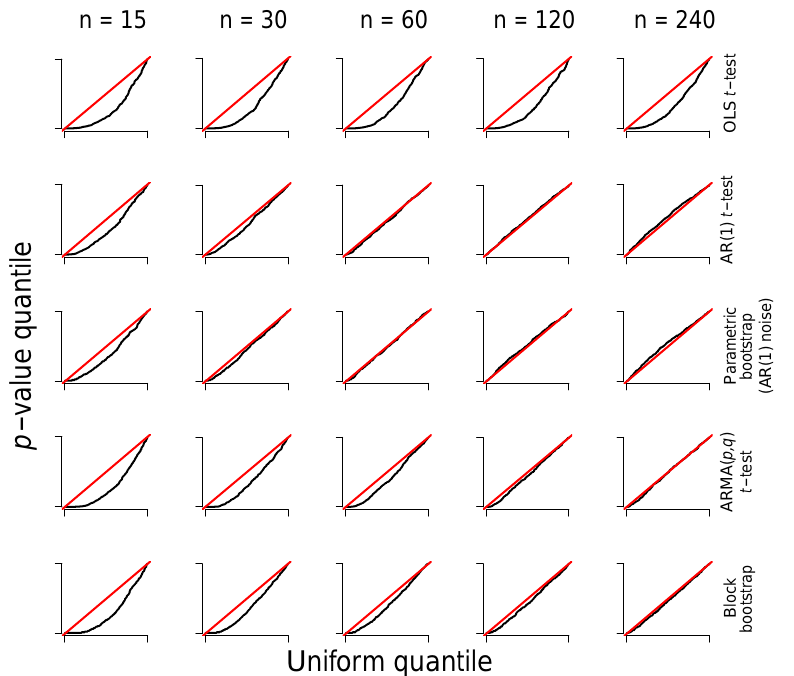
Figure 9. Same as Fig. 7 but with simulations from an ARMA(1,1) model. The p values calculated by incorrectly assuming an AR(1) model are increasingly conservative in larger sample sizes in this setting. Both blind selection via AICc and the block bootstrap are anti-conservative for small sample sizes but improve as the sample size increases.